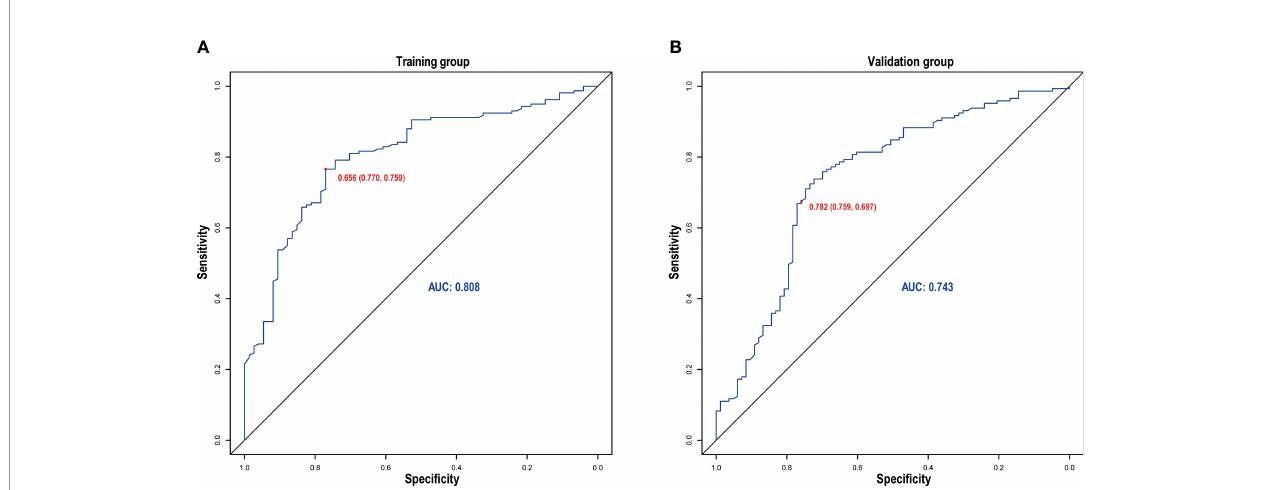
FIGURE 5 | Receiver operating characteristic curve of the nomogram in the training (A) and validation (B)